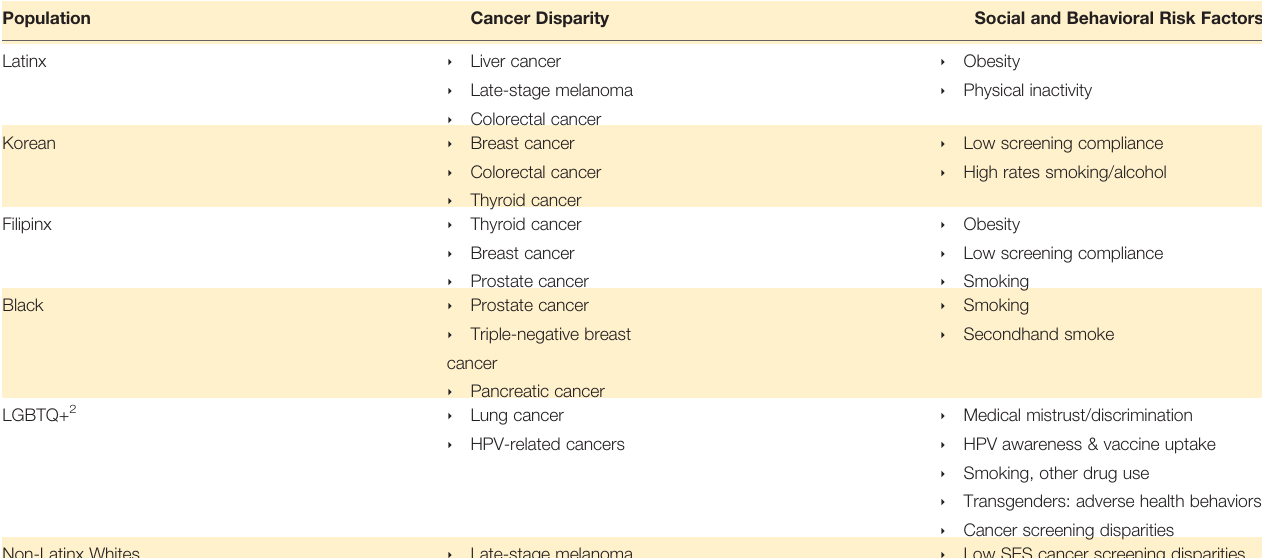
TABLE 1 | Noteworthy Disparities/Risk Behaviors in Current CSC Populations of Scienti fi c Impact.